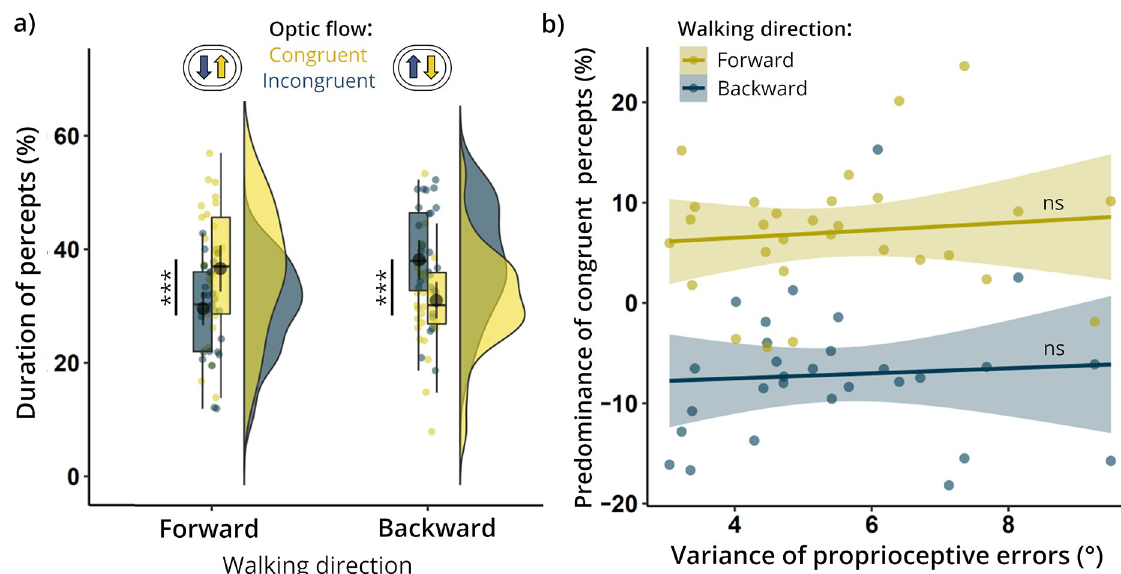
Fig 2. Effects of locomotion on perceptual awareness of optic flow patterns. ( a ) Cumulative durations of perceived congruent and incongruent percepts for each walking direction. Expanding optic flow (congruent with forward locomotion and incongruent with backward movement) dominated visual awareness independently of walking direction. ( b ) Relation between propensity to observe locomotion-congruent percepts (y-axis) and noisiness of active proprioception (x-axis). The expected negative correlations were not observed for either forward or backward locomotion. ��� p < 0.001; ns =